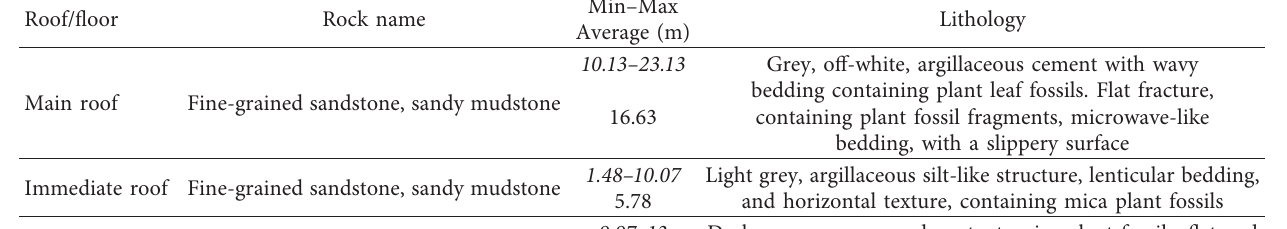
Table 1: Characteristics of coal roof and floor.